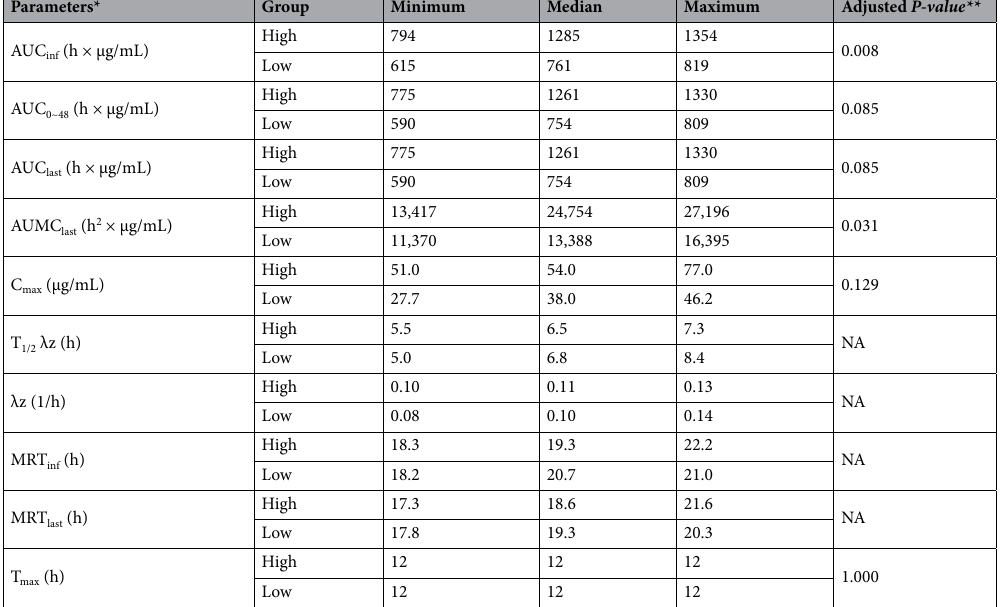
Table 5. The fecal pharmacokinetics of enrofloxacin administered to calves subcutaneously (low dose 7.5 mg/ kg, high dose 12.5 mg/kg body weight, 14 animals in each healthy and BRD combined group) computed by a non-compartmental model (i.e., statistical moments) analysis. * PK-parameters area under the curve from the time of dosing extrapolated to infinity (AUC inf ), area under the curve from the time of dosing to the last sampling time point (AUC 0~48 ), area under the curve from the time of dosing to the last measurable positive concentration (AUC last ), area under the first moment curve from dosing to the last measurable concentration